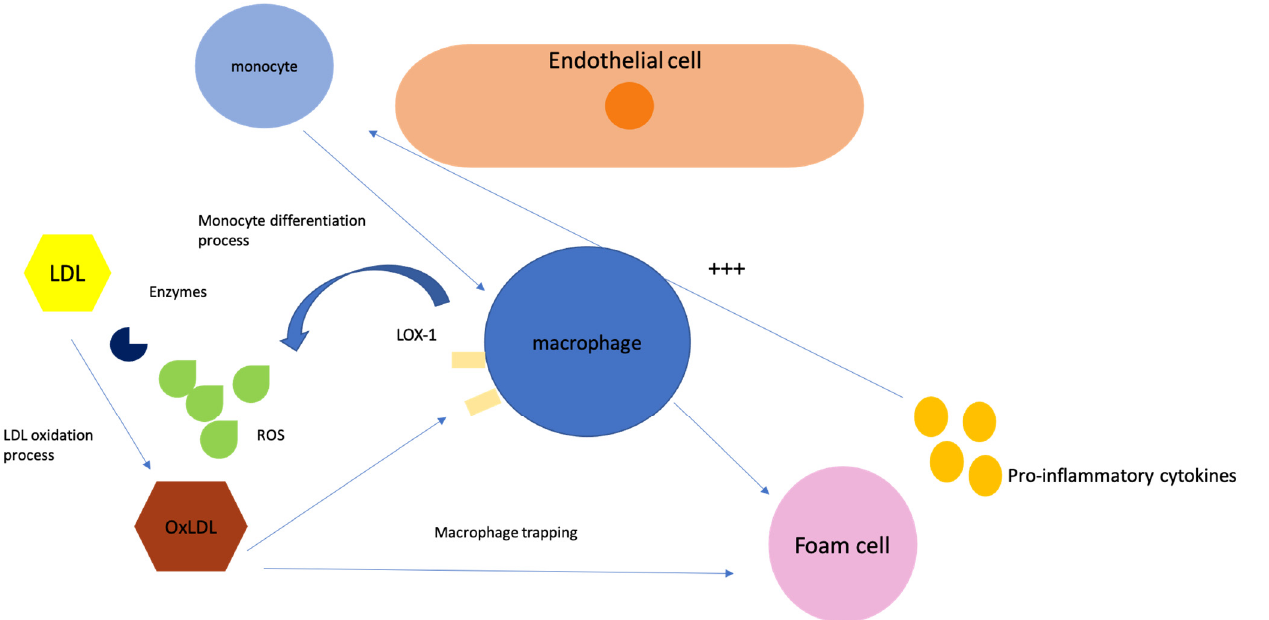
Figure 1. LDL-C oxidation process—within the sub-endothelial extracellular matrix, monocytes differentiate into macrophages that further express a series of scavenger receptors (including LOX-1 as depicted in the before-mentioned figure, alongside CD36 and toll-like receptors). Scavenger receptors generally have a high affinity for oxidized LDL (OxLDL) and are not downregulated, which ultimately leads to a significant intracellular lipid buildup. The figure also shows the macrophage trapping process, consisting of a vicious circle based on the differentiation into macrophages that promotes inflammatory processes, involving cell retention, accelerated LDL oxidation, and the recruitment of more macrophages. This eventually leads to foam cell formation and, eventually, the aggregation of OxLDL promotes foam cell apoptosis or even necrosis, creating cellular debris that is deposited within the atherosclerotic plaque and contributes to inflammatory